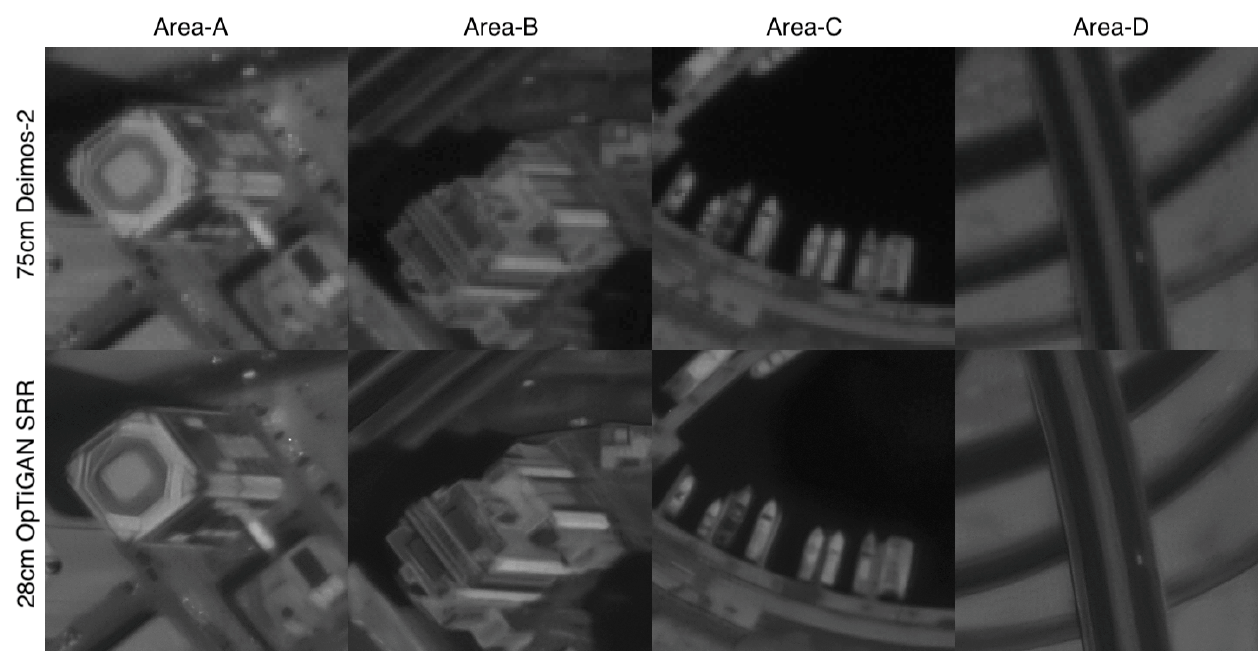
Figure 15. Examples of the 75 cm/pixel Deimos-2 image (DE2_PAN_L1B_000000_20180624T071049_20180624T071052) crops and the corresponding OpTiGAN SRR results showing building towers, ships and roads over the Dubai site. All sub-figures have a size of 87.5 m by 87.5 m. Deimos-2 image courtesy of Deimos Imaging, S.L. 2021.